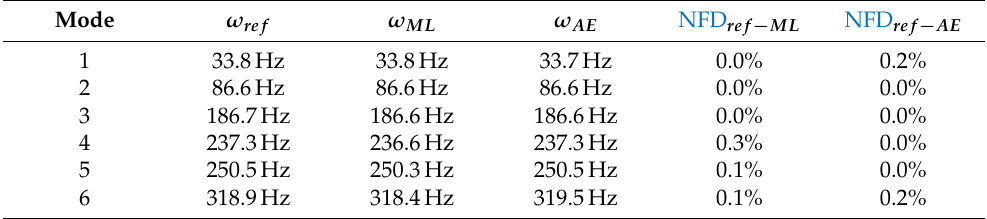
Table 3. Overview of the eigenfrequency results for the synthetic data use case (see Section 3.1) showing the absolute values and the NFD for both the MATLAB ® (ML) and AutoEMA (AE) approach. Mode ω ref ω